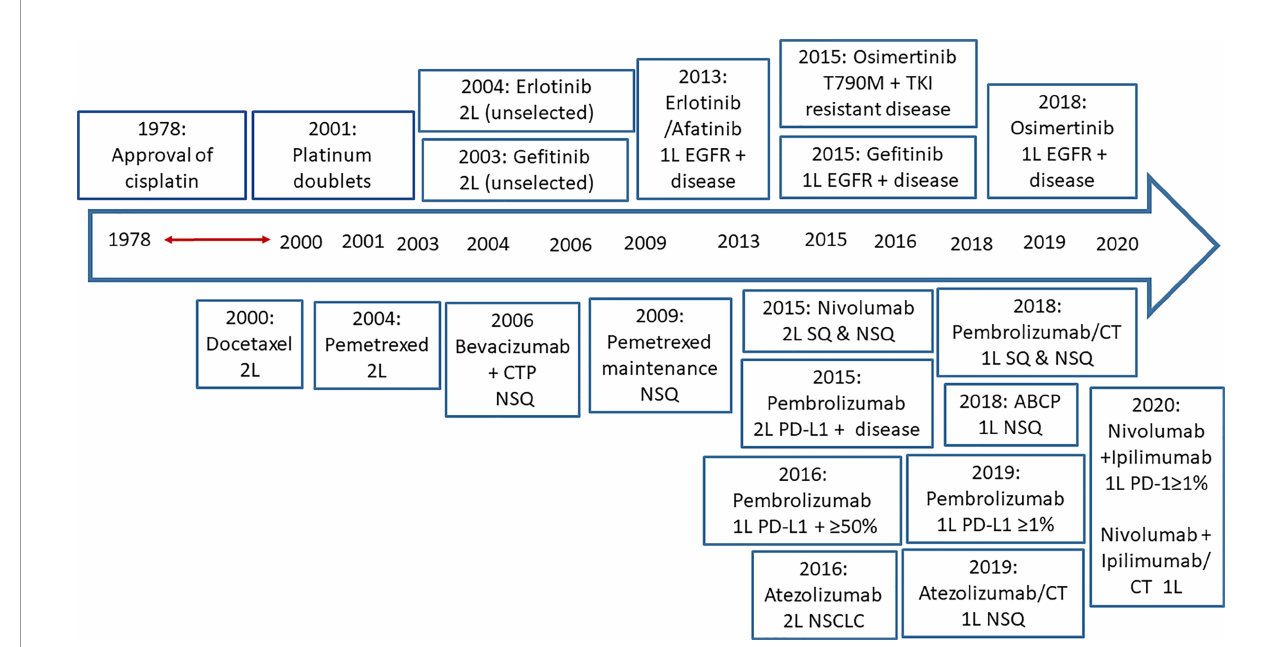
FIGURE 4 | The evolving setting of advanced NSCLC therapy: From conventional chemotherapy to EGFR TKIs and checkpoint inhibitors. SOC, standard of care; 1L, fi rst line; 2L, second line; SQ, squamous; NSQ, non-squamous; ABCP, atezolizumab-bevacizumab-carboplatin and paclitaxel.